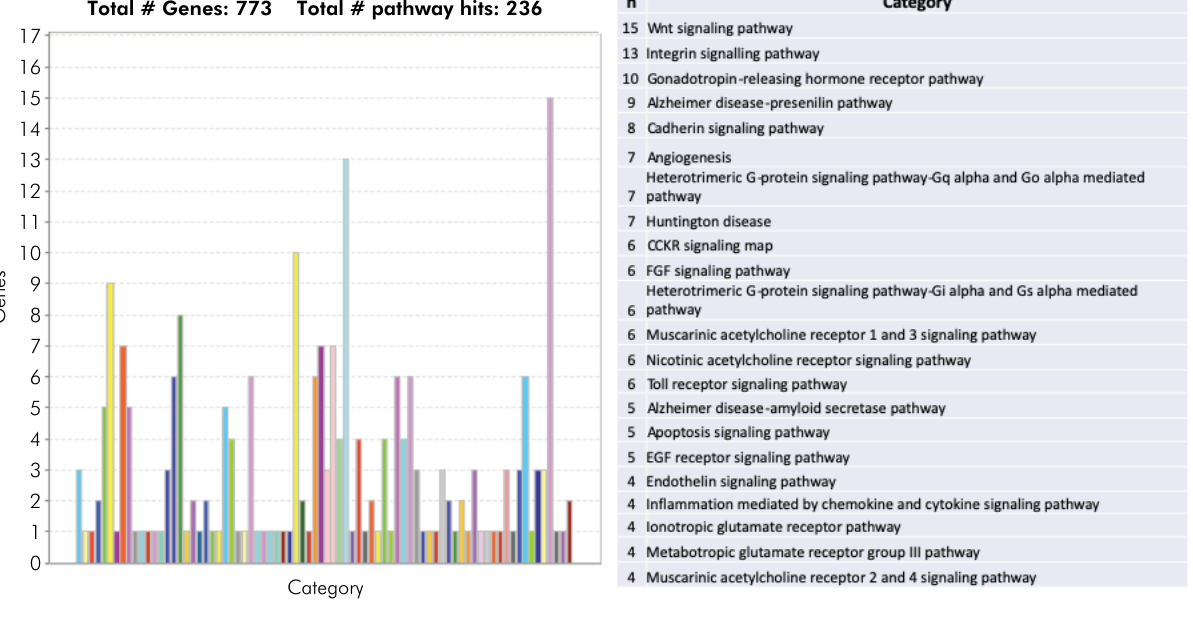
Figure 2. Most representative signaling pathways of the 773 genes associated with variants of low, moderate, and high impact on amino acid structures. Tool PANTHER Classification System (http://pantherdb.org) was